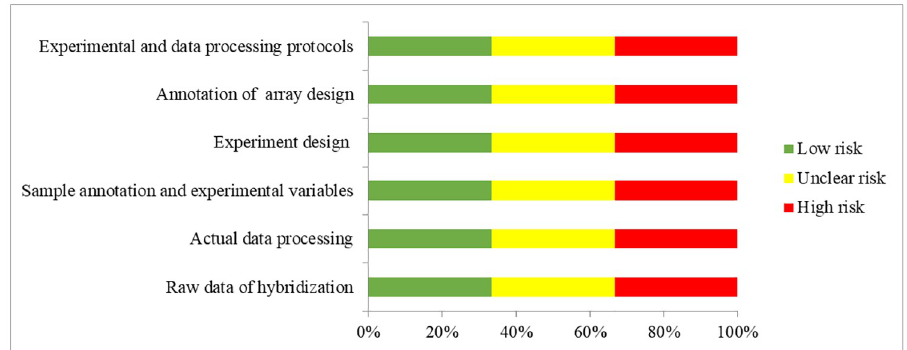
Fig 2. Quality assessment according to the MIAME guideline. Green bars, yellow bars and red bars respectively indicate the items were low risk, unclear risk and high risk.